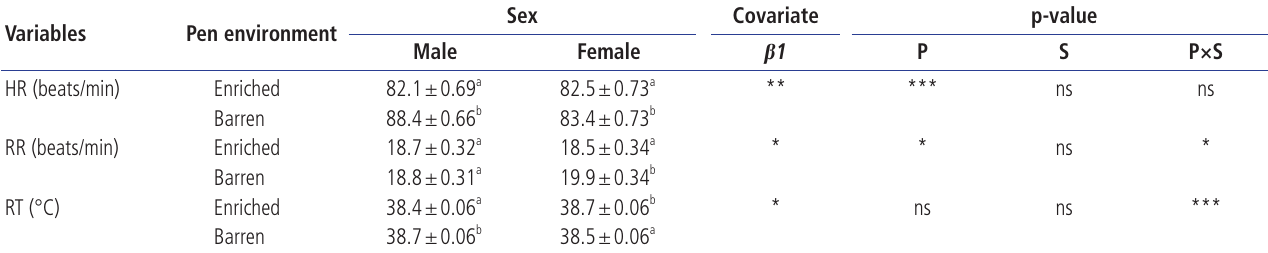
Table 2. Interaction between pen environment and sex on physiological responses of Windsnyer pigs